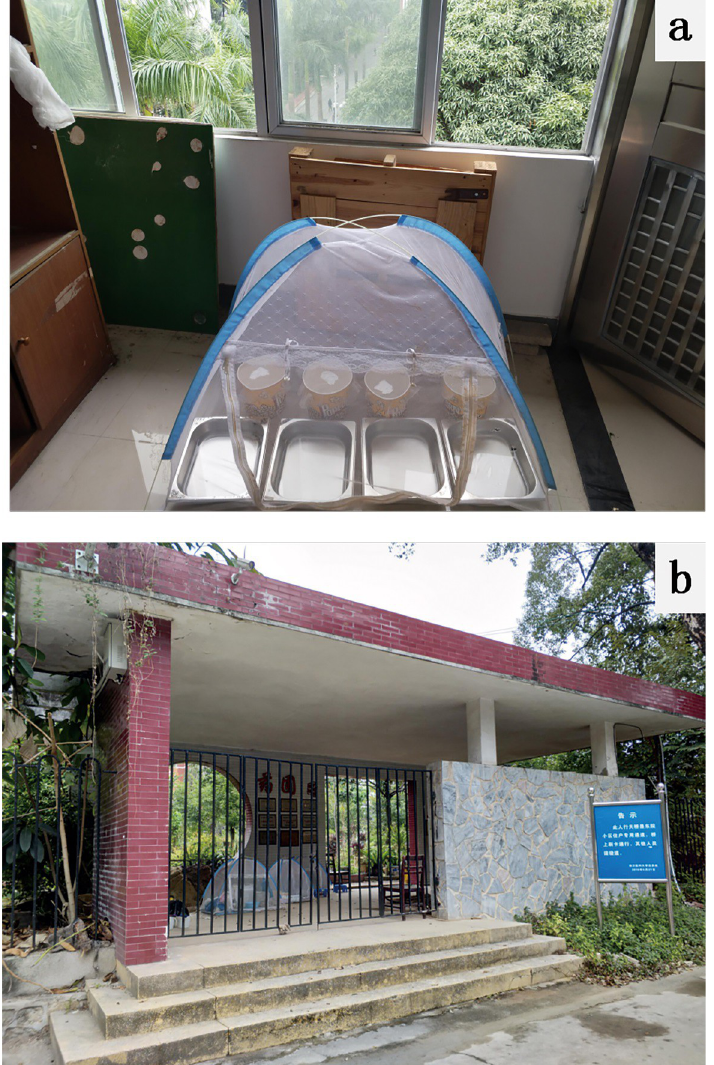
Fig 3. Picture illustrating the different settings used in the experiment. A: Semi-field setting, B: Semi-natural setting.